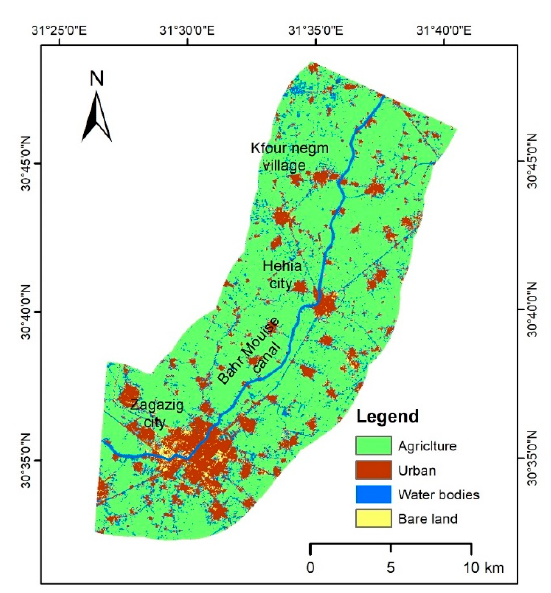
Figure 2. The main land cover land use (LCLU) classes around the Bahr Mouise canal.